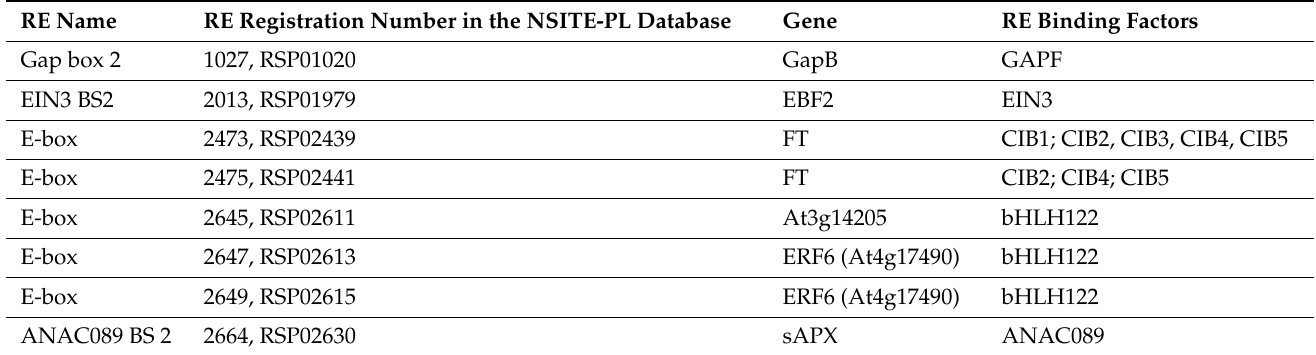
Table 1. Information on the regulatory element (RE) found in the singular 135 bp VaSTS11 intron sequences in the NSITE-PL database*.